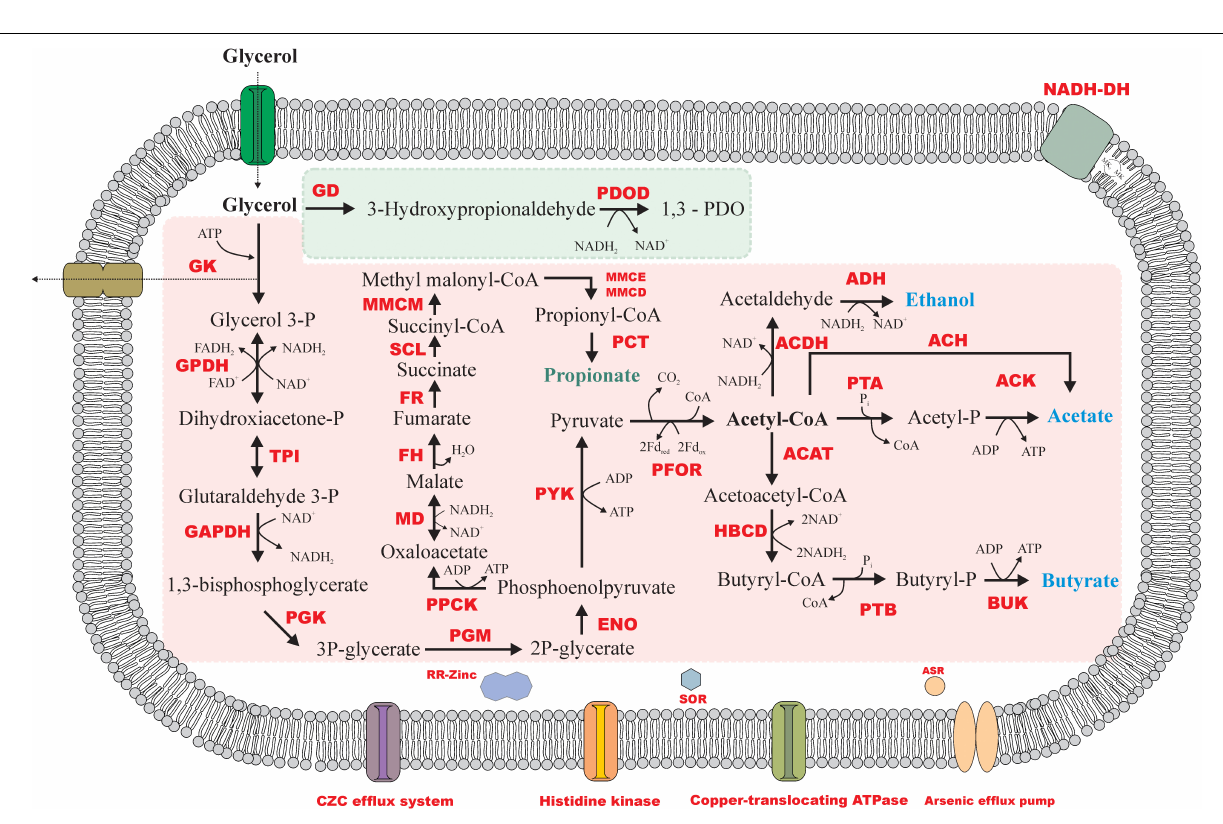
Frontiers in Microbiology |